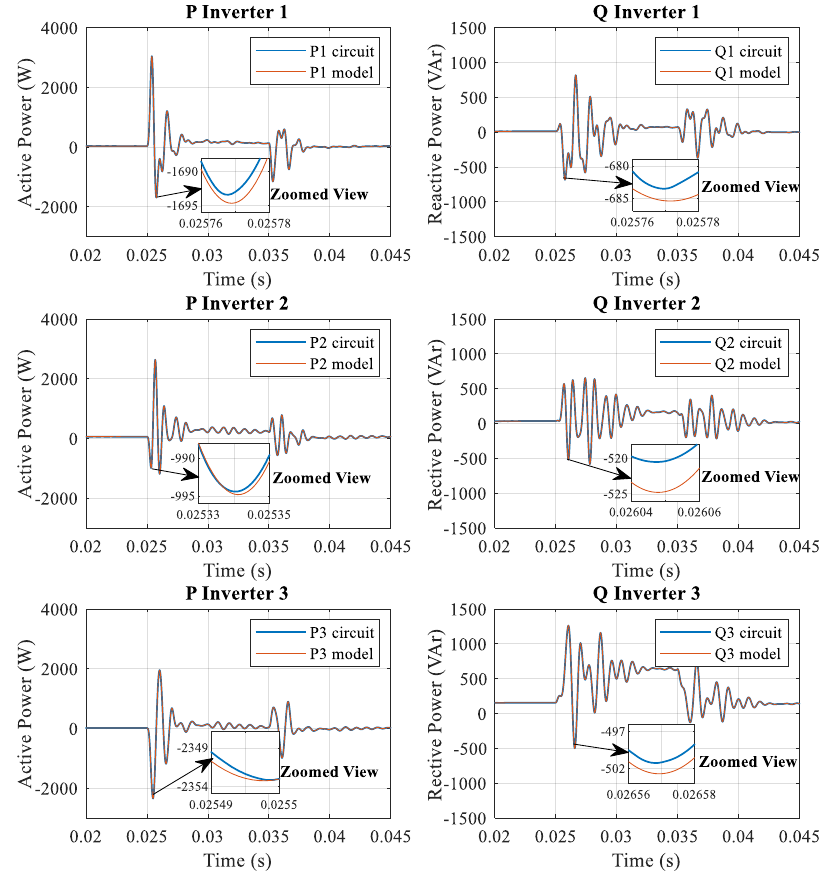
Figure 11. Power waveforms for the mathematical model and the circuit in islanded mode.